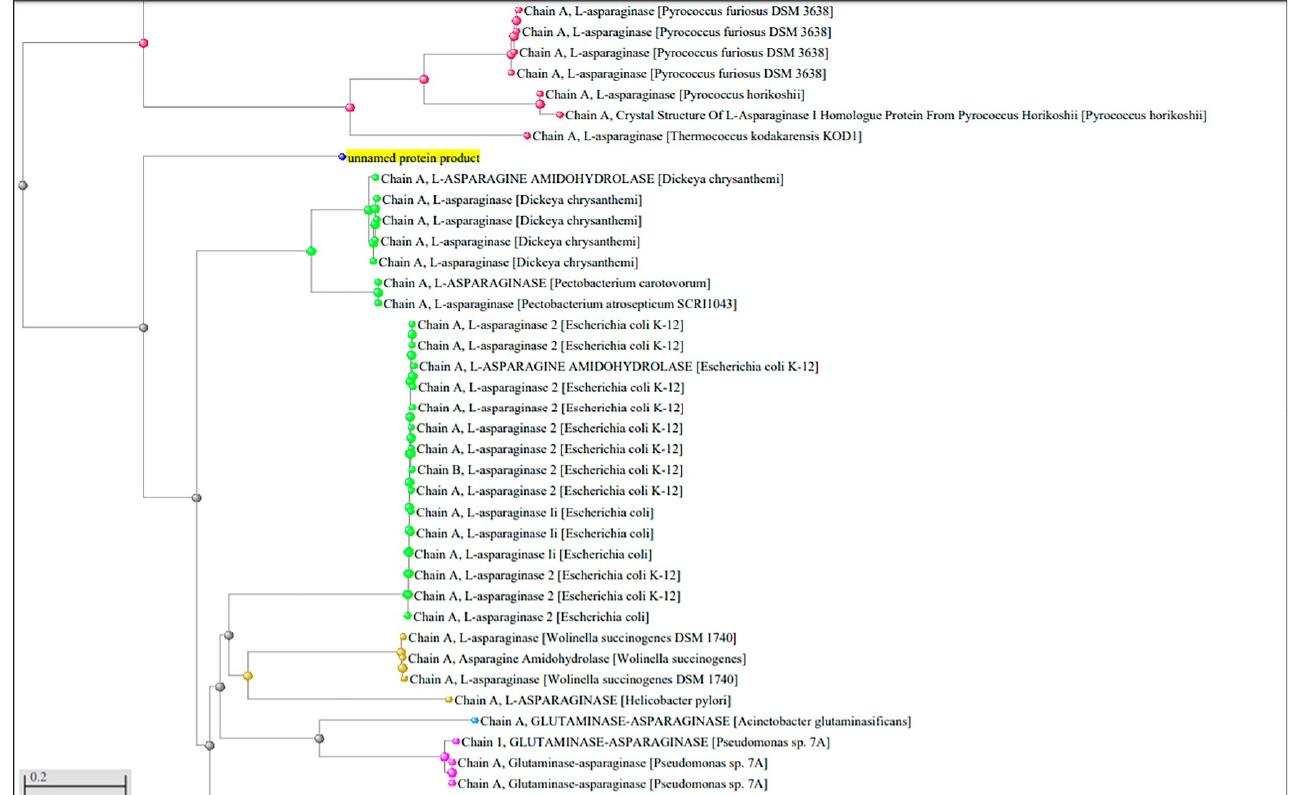
Figure 2. Phylogenetic tree based on the L ‐ asparaginase sequence of P. sizovae compared to proteins that already have the crystallographic structure elucidated. Grishin evolutionary distance used as measure.